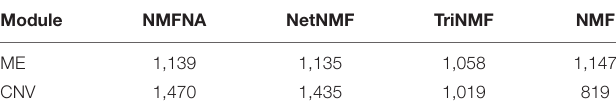
TABLE 6 | Numbers of common genes in ME and CNV core